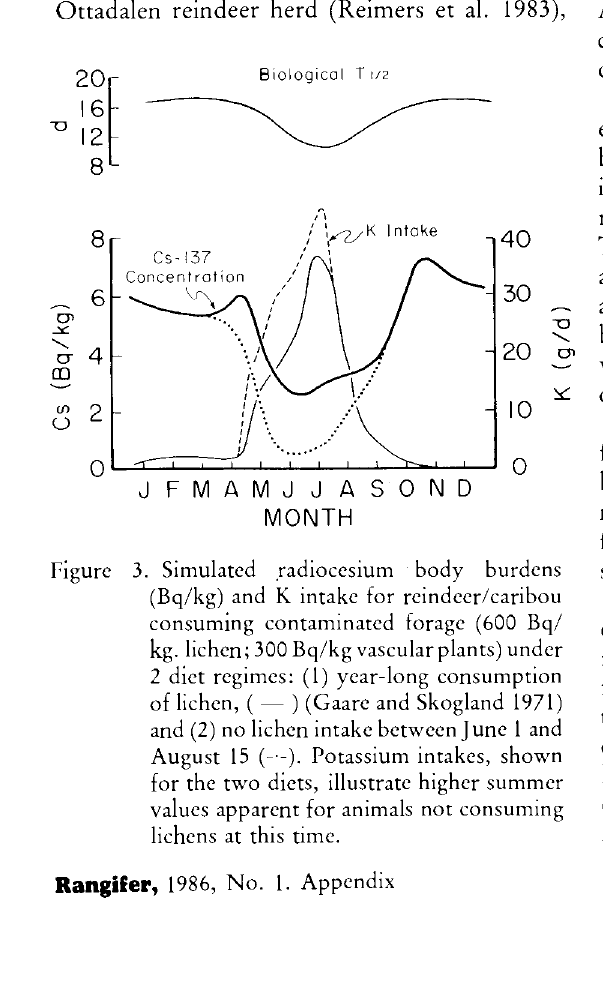
food intakes (White 1983), diet composition